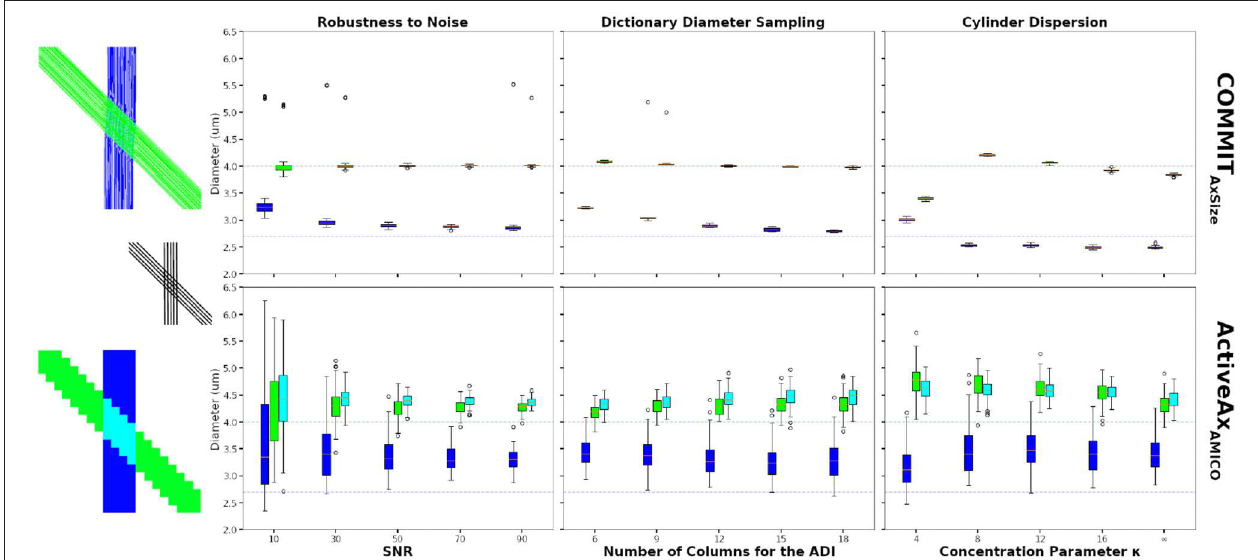
FIGURE 4 | Axon diameter indexes (ADI) estimated on the 45-degrees crossing synthetic phantom. The figures show the bundle-specific ADI estimated using the COMMIT AxSize method (top row) and the voxel-wise ADI estimated using the ActiveAx AMICO method (bottom row). The boxplots show the results 50 different Rician noise realisations for COMMIT AxSize and 100 voxels sampled in each single bundle areas and in the crossing area, for the ActiveAx AMICO method. The mean ground truth cylinder diameter of the green and blue bundles are 4.0 µ m , and 2.7 µ m , respectively (colored dashed line). The first boxplot column show the estimated ADI at various SNR, the second column using various number of columns in matrix A to compute the ADI and the last column shows the estimates for data with various levels of dispersion.